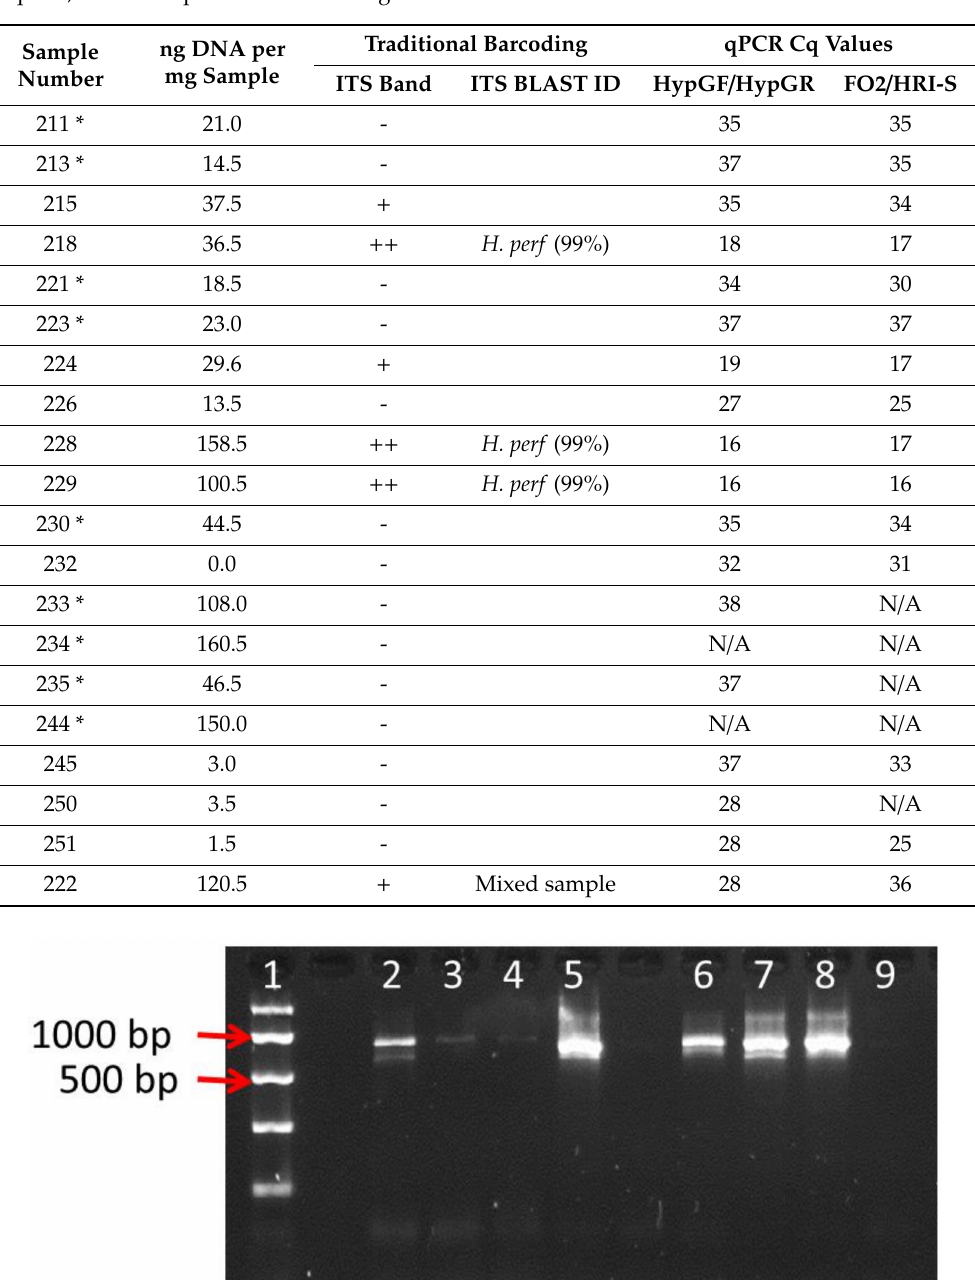
Table 2. Traditional barcoding, and qPCR results. Traditional barcoding results describe the presence of a detectable band after gel electrophoresis: - not detectable, + detectable, ++ strongly detectable. For those bands that provided sequence information, the top result of a BLAST search is shown. Samples marked with * were deemed as not suitable for further DNA based analysis, having given no results in traditional PCR and generic qPCR testing methods. Cq results are shown for the original primers used in qPCR, rounded up to the nearest integer.